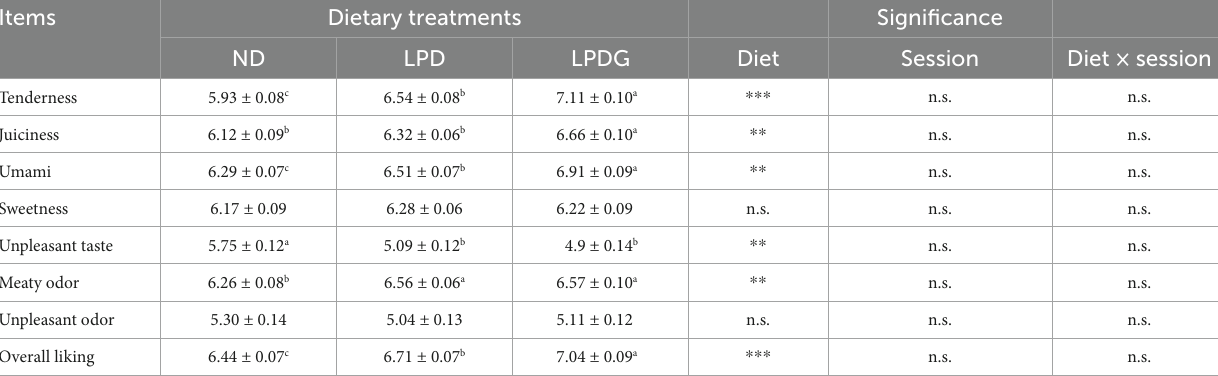
TABLE 2 Sensory panel evaluation of pork loin from growing-finishing pigs receiving a normal, low protein, or low protein supplemented with glycine diet. Items Dietary treatments Significance